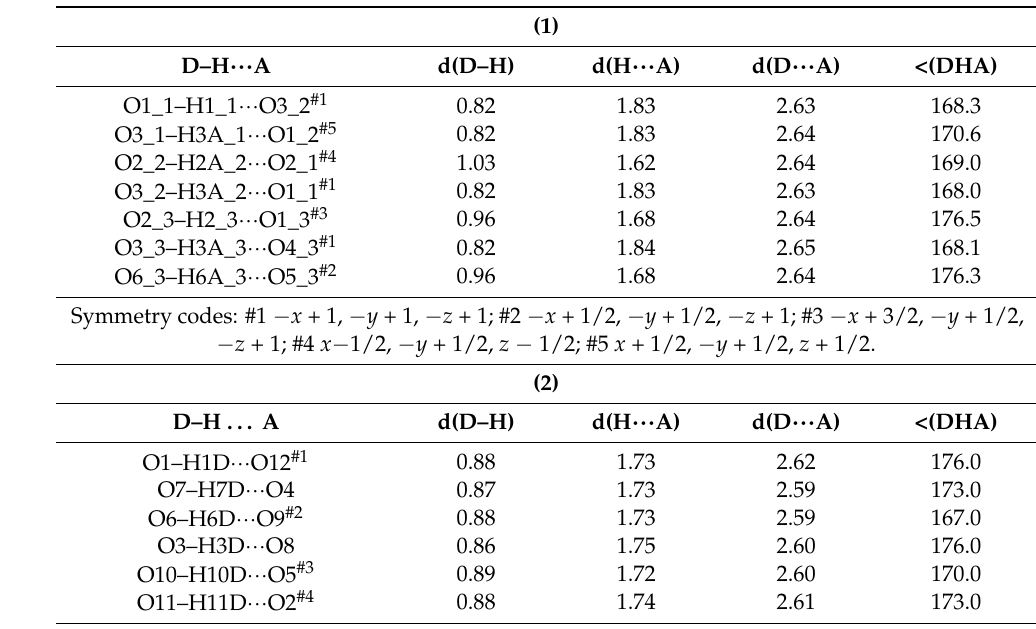
Table 2. Hydrogen bond parameters (Å, ◦ ) for the crystal structures of ( 1 )–( 5